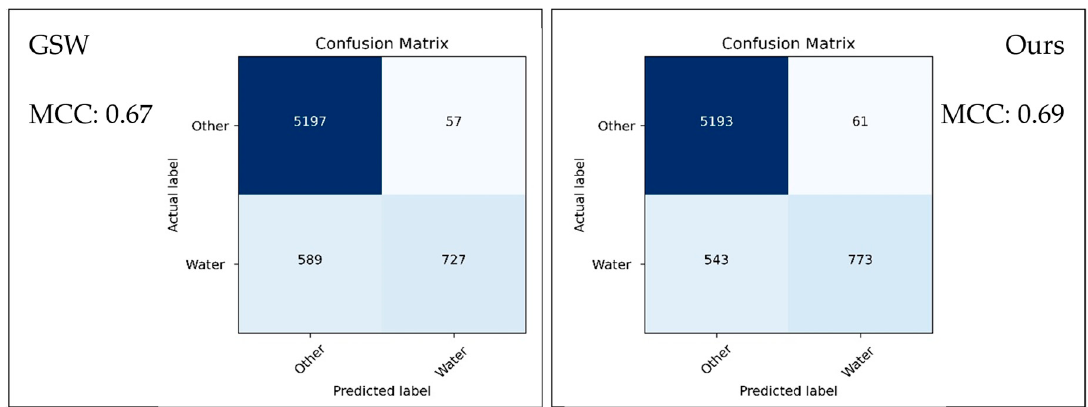
Figure 5. Comparison of misclassified pixels between the 2018 South African National Land Cover (SANLC) validation points and the 2018 Global Surface Water (GSW) water ( left ) and the 2018 detected surface water using the current method ( right ).